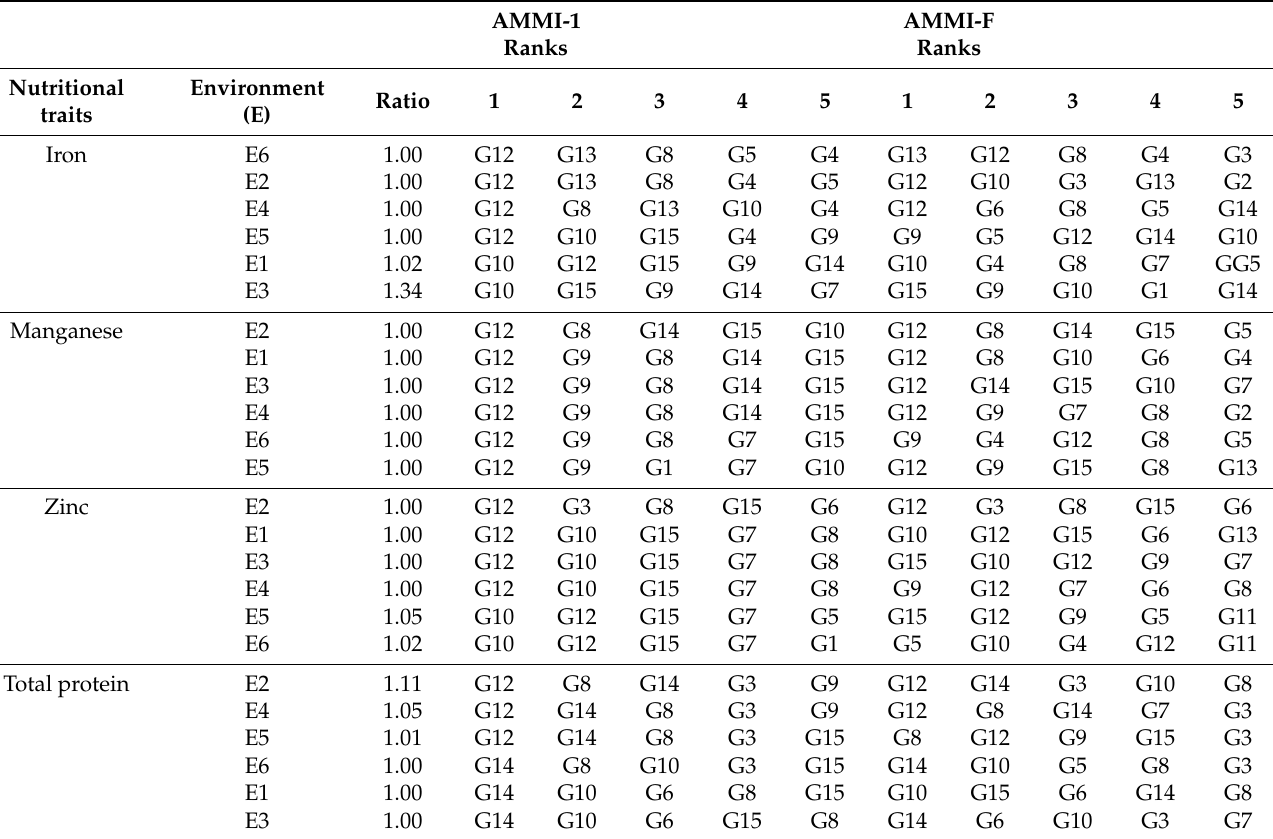
Table 5. Winning cowpea genotypes evaluated across six test environments of South Africa for nutrient